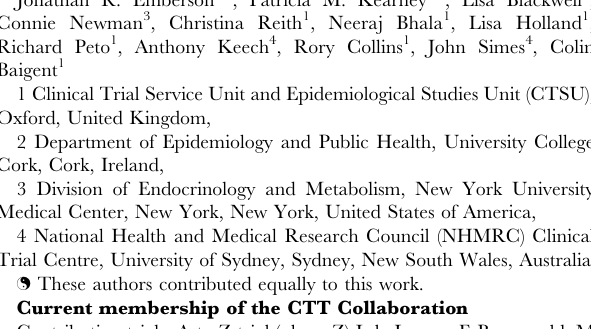
Figure S1 Effects of statin therapy on cancer incidence, by duration of treatment. Figure S2 Effects of statin therapy on cancer mortality, by duration of treatment. Figure S3 Effects of statin therapy on cancer incidence, by baseline LDL cholesterol. Figure S4 Effects of statin therapy on cancer mortality, by baseline LDL cholesterol. Figure S5 Effects of statin therapy on cancer incidence, by age and sex. Figure S6 Effects of statin therapy on cancer mortality, by age and sex. Figure S7 Effects of statin therapy on cancer incidence, by other baseline characteristics. Figure S8 Effects of statin therapy on cancer mortality, by other baseline characteristics. Figure S9 Effects of statin therapy on cancer incidence in 22 statin vs. control trials, by type of statin. Figure S10 Effects of statin therapy on cancer mortality in 22 statin vs. control trials, by type of statin. Table S1 Number of patients with a report of cancer (number of cancer deaths), by site and trial. Table S2 Cancer incidence and cancer mortality by site, in 22 trials of statin vs. control and 5 trials of more vs. less